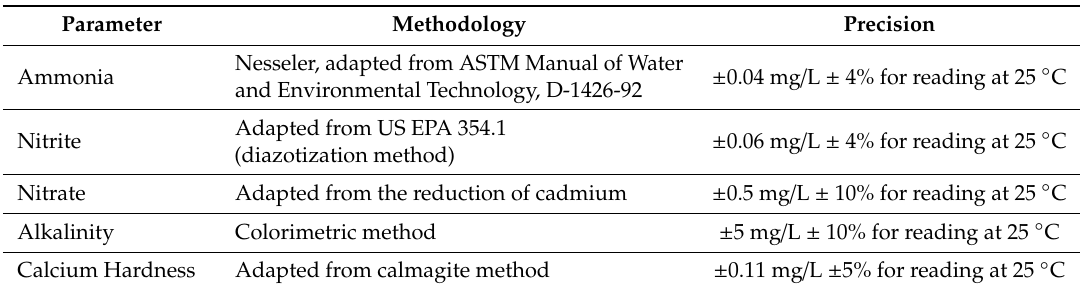
Table 4. Methodology and precision for the determination of parameters using a Hanna HI 83099